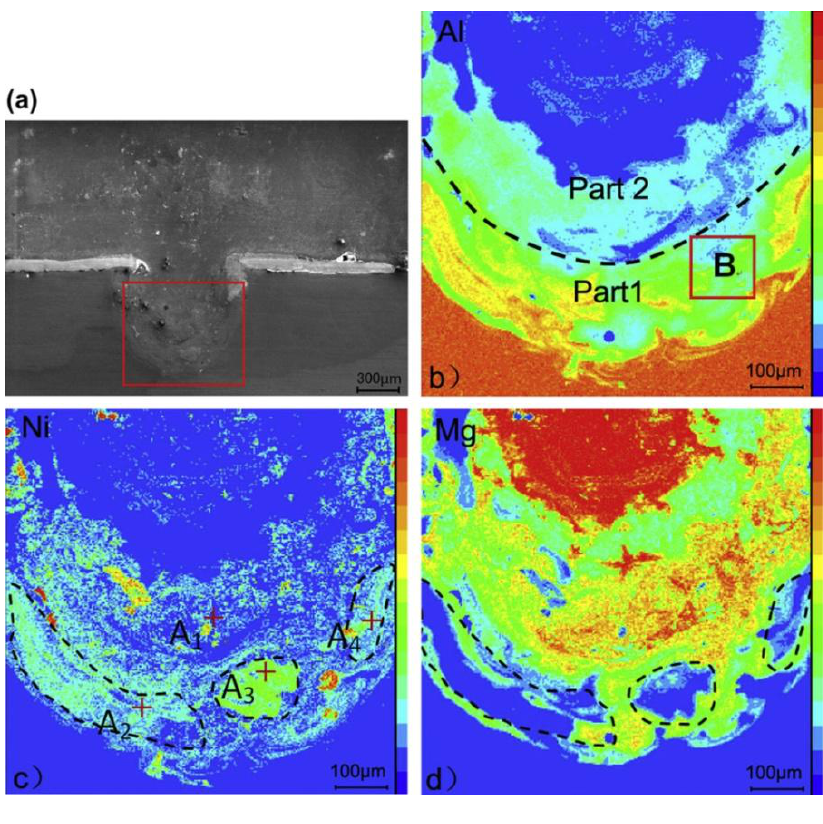
Figure 13. The macrostructure and element distributions of the laser-arc-adhesive hybrid welding of Mg to Al joint with Ni interlayer [83]. ( a ) Macrostructure; ( b ) element Al; ( b ) element Ni, ( d ) element